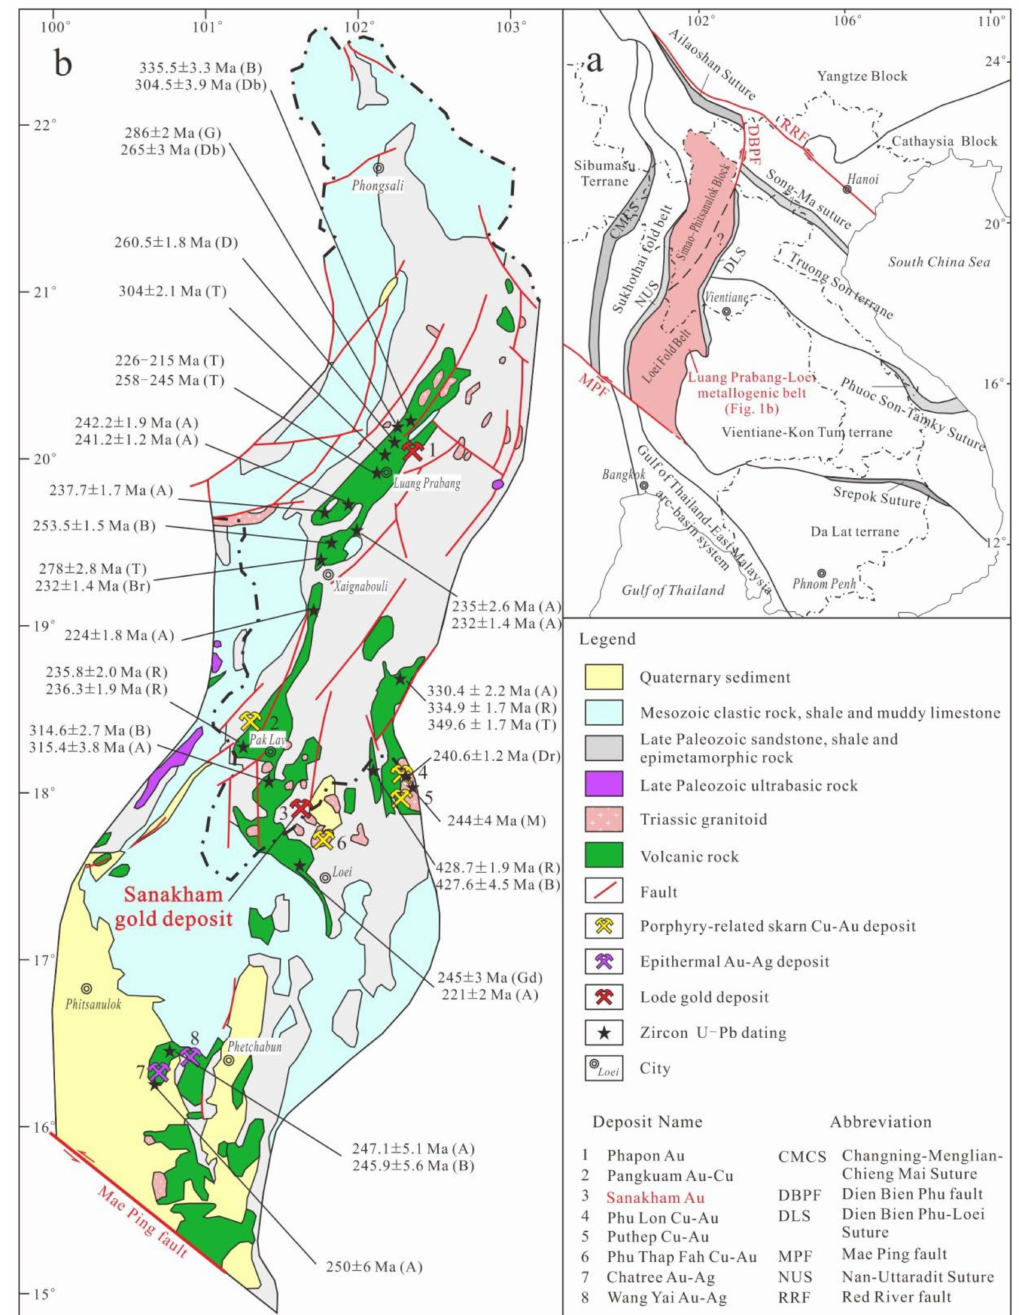
Figure 1. Regional geological map. ( a ) Simplified tectonic map showing structural units of Laos andadjacent regions; ( b ) simplified geological map of the Luang Prabang–Loei metallogenic belt (geochronological data from [4–16], modified from [5,10]). A = andesite; B = basalt; Br = breccia; D = dacite; Db = diabase; Dr = diorite; G = gabbro; Gd = Granodiorite; M = monzonite; R = rhyolite; T =